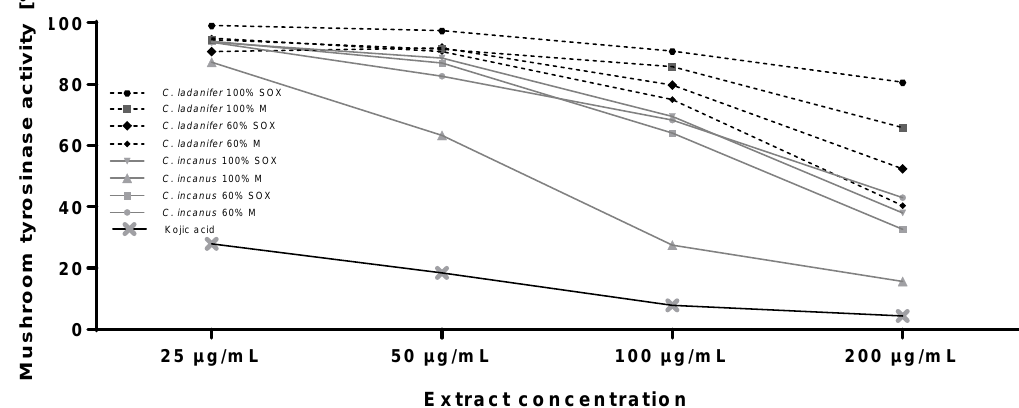
Figure 1. Inhibition of mushroom tyrosinase by C. incanus and C. ladanifer extracts in comparison with kojic acid; data on graphs represent mean values ( n = 3).